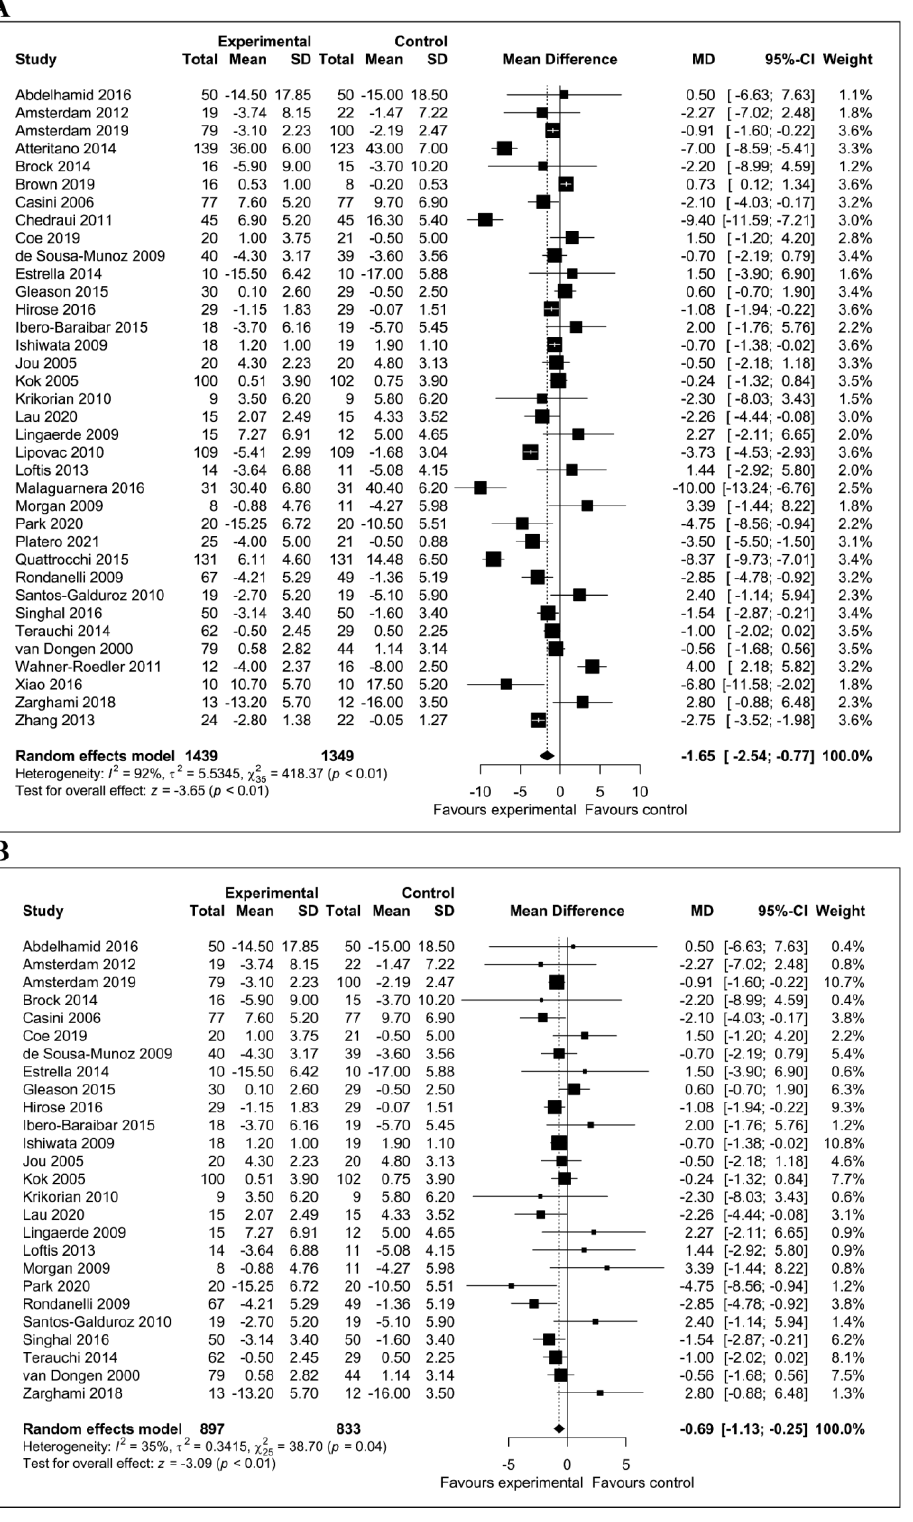
Figure 2. Forest plots showing the effects of flavonoid consumption on depressive symptoms . ( A ) Forest plot of the effect of dietary flavonoids on depressive symptoms in 36 clinical trials. ( B ) Sensitivity analysis summarizing the effect of flavonoids on depressive symptoms.